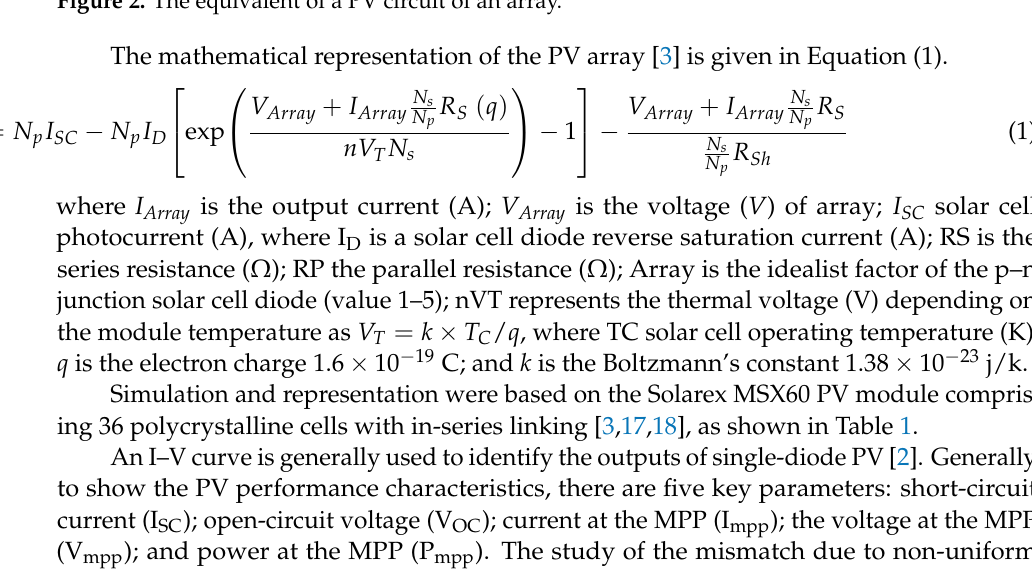
Figure 2. The equivalent of a PV circuit of an